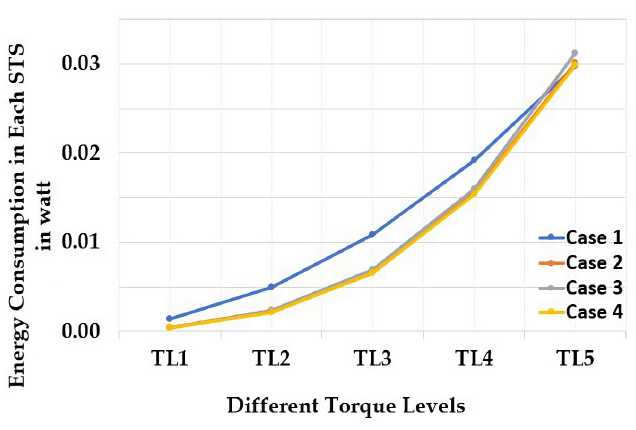
Figure 6. The energy consumption for sit to stand with different Q and R matrices and torque